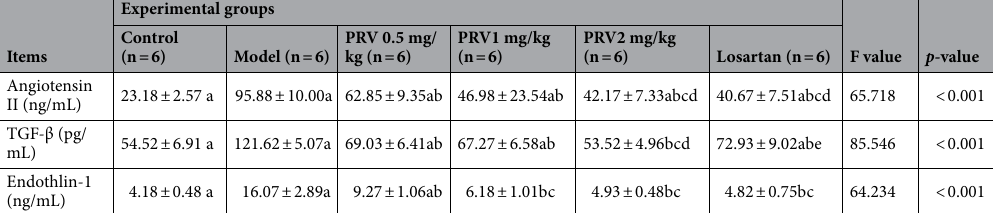
Table 3. Mean ± SD for biochemical analysis of serum hypertension indexes in different experiemntal groups. The results are presented as the means ± standard deviation (SD). The groups with different superscripts in the same row are significantly different ( p < 0.05), a: control group; b: model (dexamethasone-treated) group; c: PRV 0.5 mg/kg group; d: PRV1mg/kg group; e: PRV 2 mg/kg group. n number/group, PRV propolis, royal jelly & bee venom, TGF-β transforming growth factor